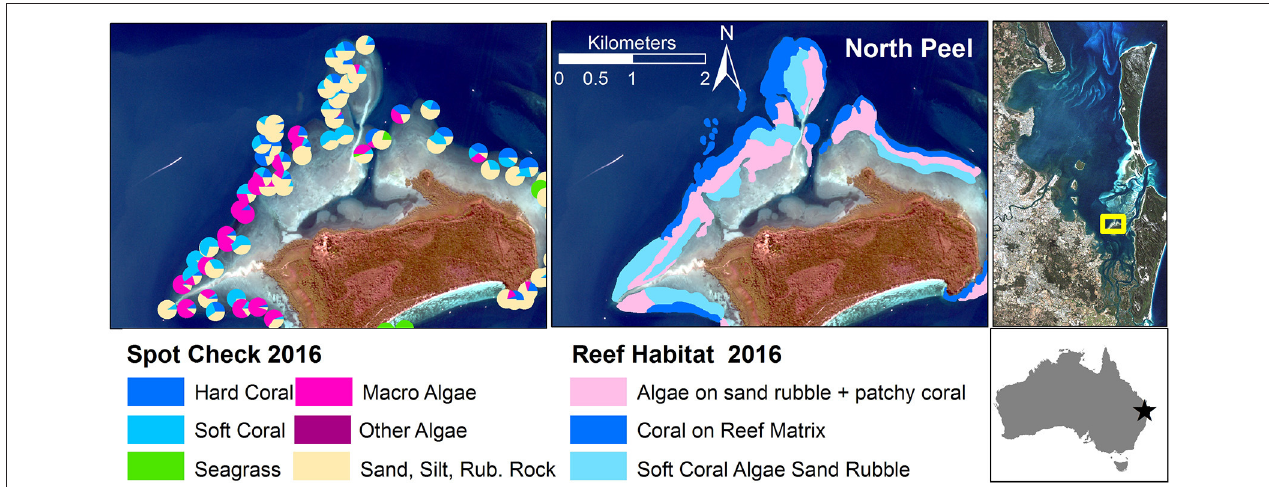
FIGURE 2 | Map of the benthic cover categories such as obtained by Reef Check Australia volunteers, showing the benthic category proportion at each site, and the consolidated reef habitat map around Peel Island, Moreton Bay, Australia.